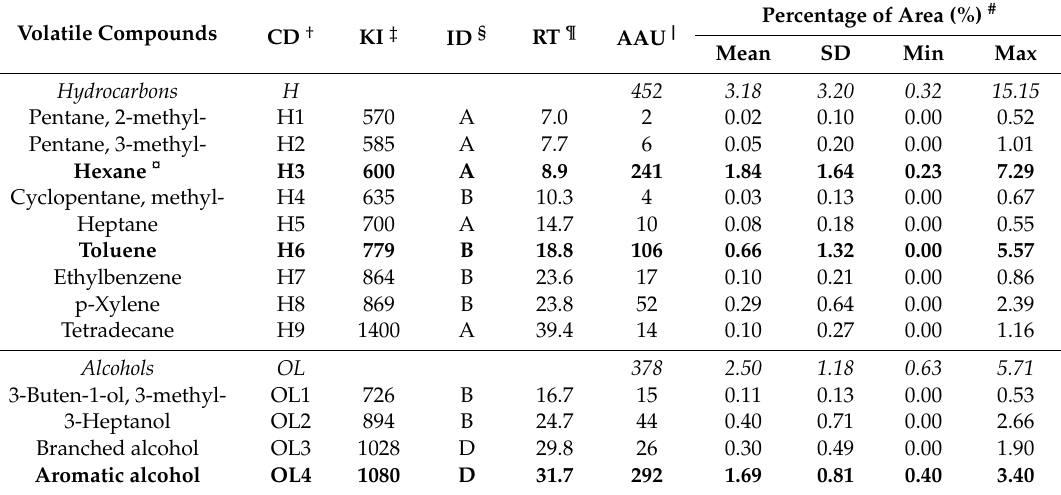
Table 1. Volatile compounds in the fresh fig samples